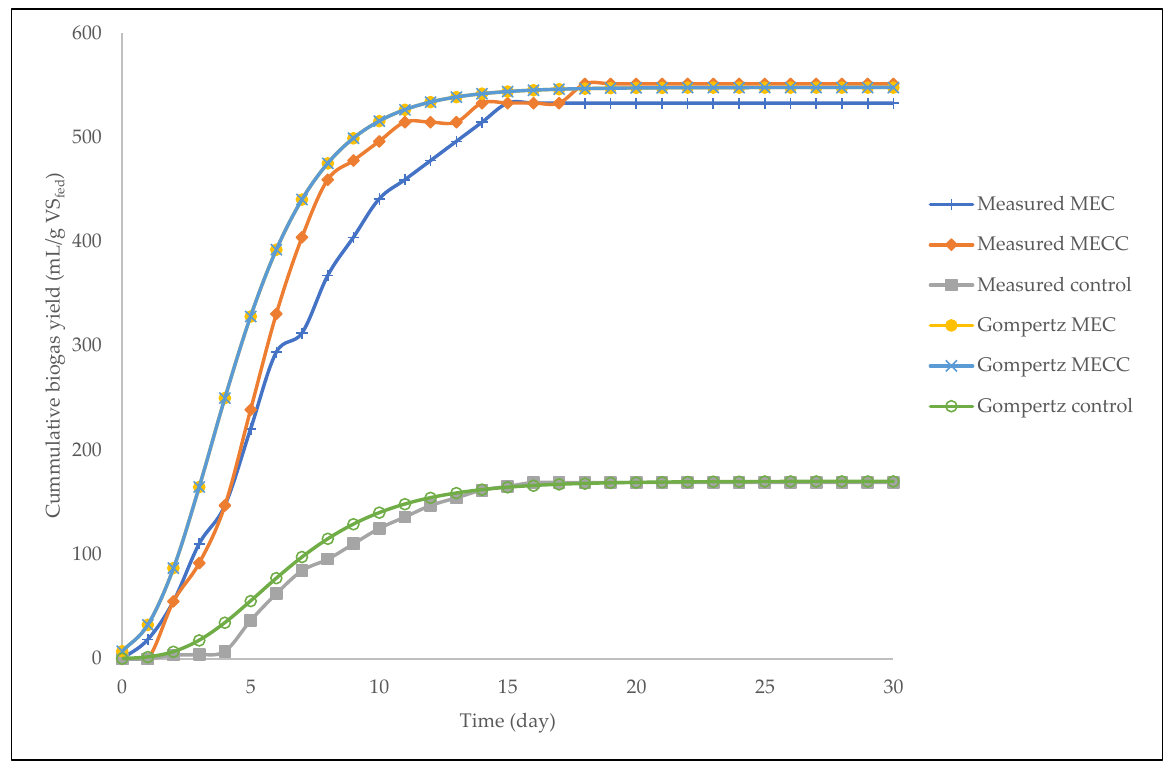
Figure 10. Cumulative biogas yield from the modified Gompertz model. Table 2. Predicted kinetic parameters for the modified Gompertz models.